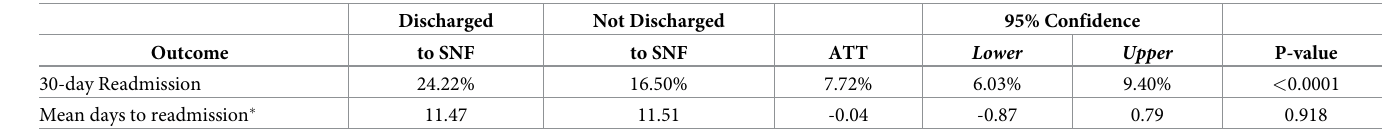
Table 3. Results of a propensity score matching analysis for 30-day readmission (discharge to SNF treated as the treatment effect; 1:1 matching).